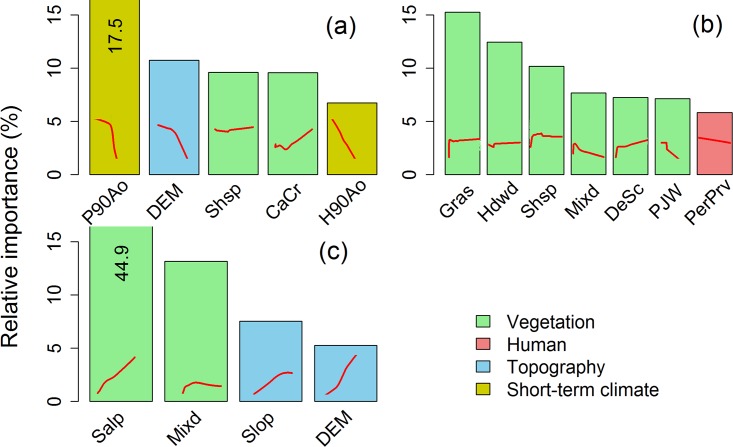
Relative influences of variables that explained greater than 5% of the variation and marginal effects (red trend lines within each bar) from boosted regression tree models for (a) large fire occurrence, (b) fire size, and (c) percent of high severity burning.Values are specified for truncated bars. Abbreviations of predictor variables and their corresponding full names are described in Table 1.